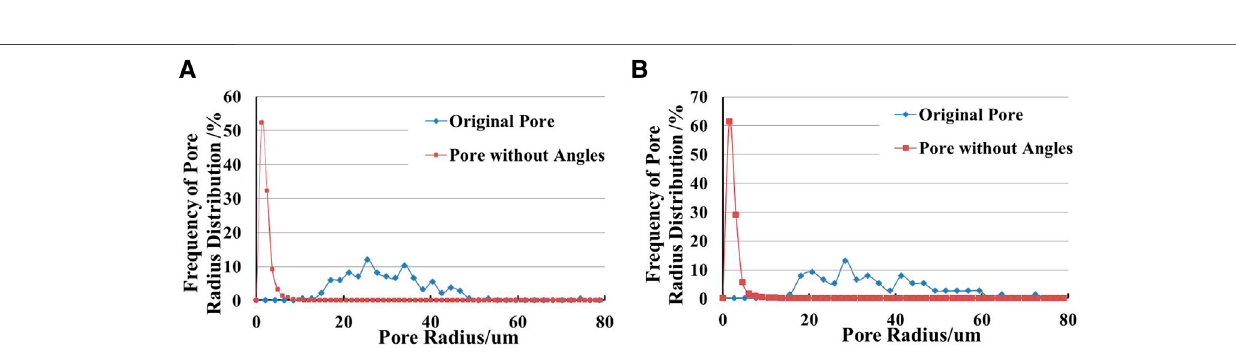
FIGURE 3 | Comparison of pore radius distribution. (A) Sample 1. (B) Sample